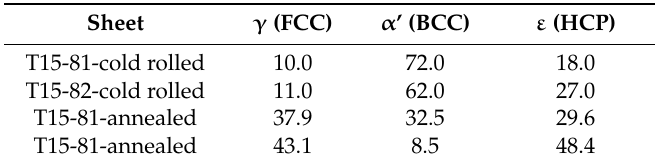
Figure 2. Microstructures of cold rolled and annealed state of both TWIP (Twinning induced plasticity) sheets: ( a ) Cold rolled sheet T15-81; ( b ) Cold rolled sheet T15-82; ( c ) Sheet T15-81 with the lower volume fraction of ε -martensite; and, ( d ) Sheet T15-82 with the higher volume fraction of ε -martensite. Table 3. Volume fractions of phases determined by X-ray